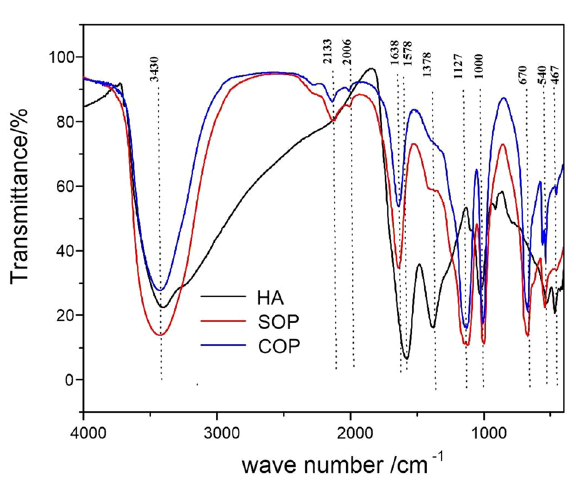
Figure 5. Effect of the initial pH on the catalytic ozonation of HA ( a ) and changes in the pH among the different process ( b ) (experimental conditions: catalyst dosage, 5.0 g/L; gas flow rate, 400 mL/min; ozone concentration, 2.90 mg/L; reaction volume, 1.0 L; and reaction time, 30 min).